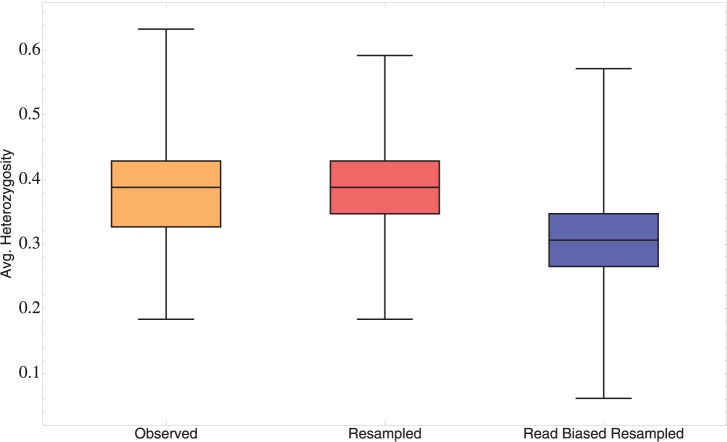
Estimated effect of low coverage in the Iceman genome on mean heterozygosity at GWAS loci.Box plot illustrating the distribution of observed mean heterozygosity across 49 GWAS SNPs in present Europeans from the 1000 Genomes Project (Orange), the expected distribution of mean heterozygosity based on resampling from allele frequencies in Europe (Red), and the expected distribution of mean heterozygosity based on allele frequencies in Europe and random sampling of alleles according to the distribution of read coverage in the Iceman (Blue). Although there is a significant reduction in mean heterozygosity, the range of values is similar, suggesting that the observed reduction of heterozygosity in the Iceman compared to present Europeans is genuine.